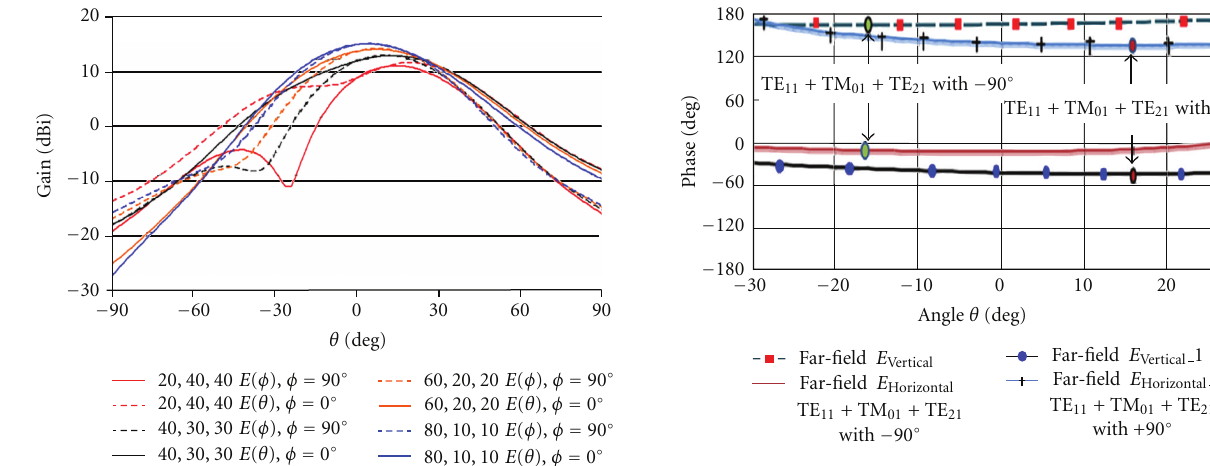
Figure 4: The triple-mode feedhorn copolarization gain patterns with variable amplitude contents in TE 11 + TM 01 + TE 21 modes at 7.73 GHz for +90 ◦ fixed phase. Power contents in modes are mentioned as percentage.